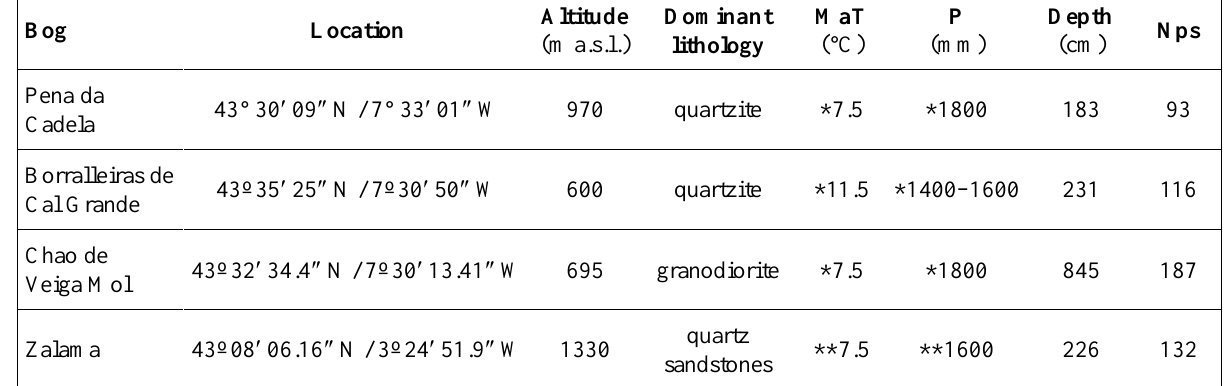
Table 1. Characterisation of the sampled bogs. Climatic data according to *Martínez-Cortizas & Pérez-Alberti (1999) and **Heras (2002). MaT = mean annual temperature, P = annual precipitation, Nps = number of peat samples